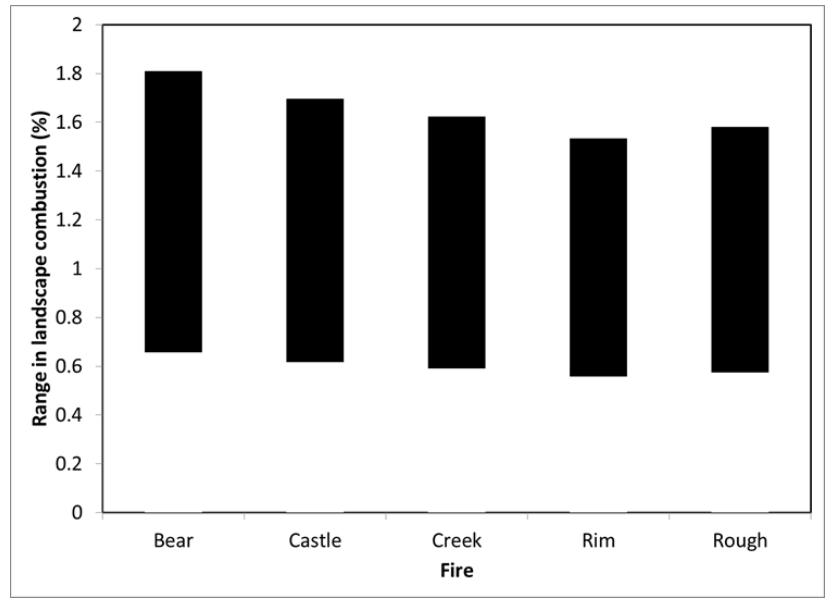
Figure 5. Landscape-level estimates for aboveground woody biomass combustion for five large, severe fires in the California Sierra Mountains. The range presented is for the various stand structures presented in Figure 4.